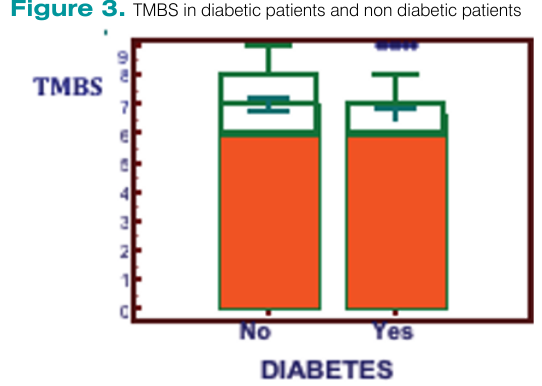
Figure 3. TMBS in diabetic patients and non diabetic patients